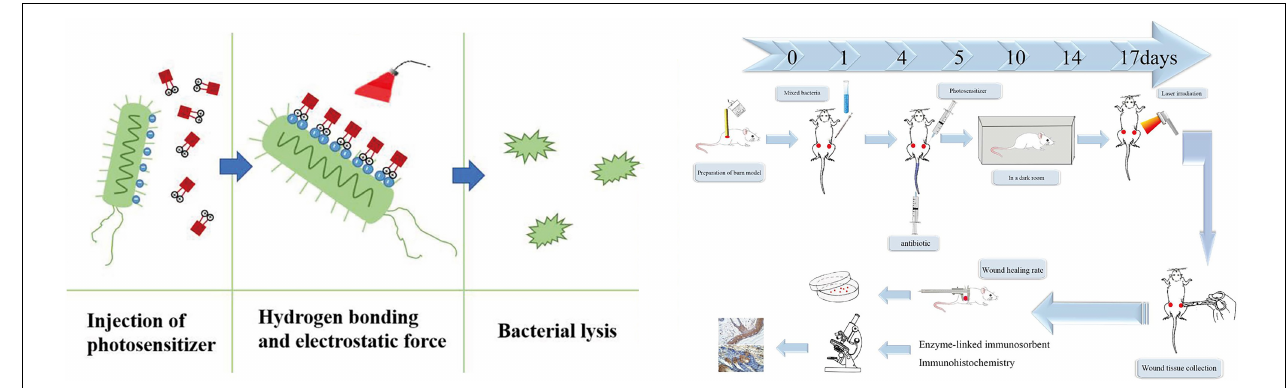
FIGURE 1 | Diagrammatic representation of the model of skin burn wound infection treatment by antimicrobial photodynamic therapy.